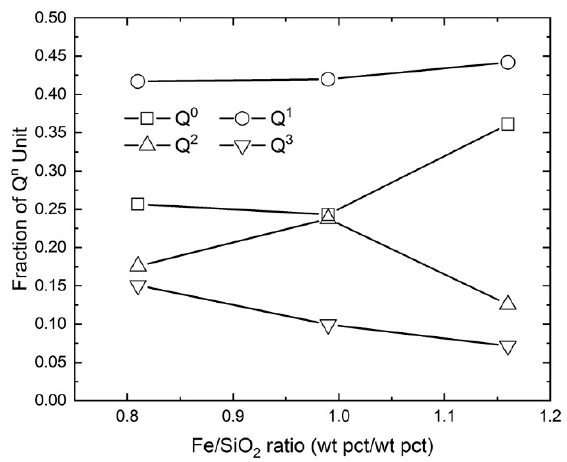
Figure 4. The abundance of structural units in FCSM slag as a function of Fe/SiO 2 ratio ( p O 2 = 10 − 8 atm and T = 1300 °C).